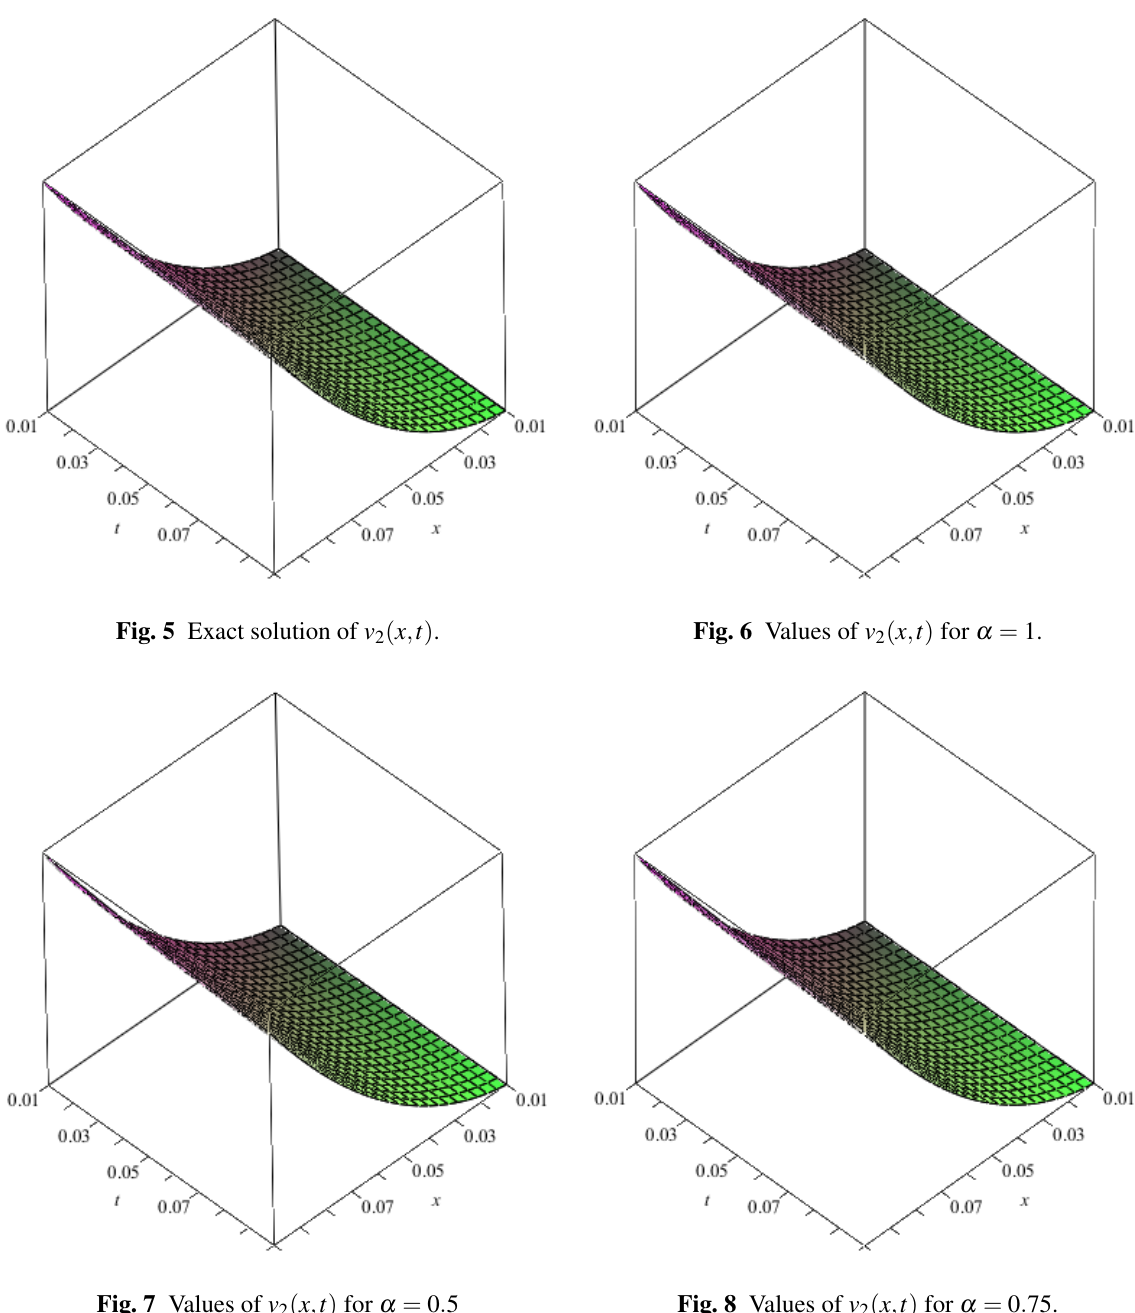
Fig. 7 Values of v 2 ( x , t ) for α = 0 . 5 Fig. 8 Values of v 2 ( x , t ) for α = 0 .